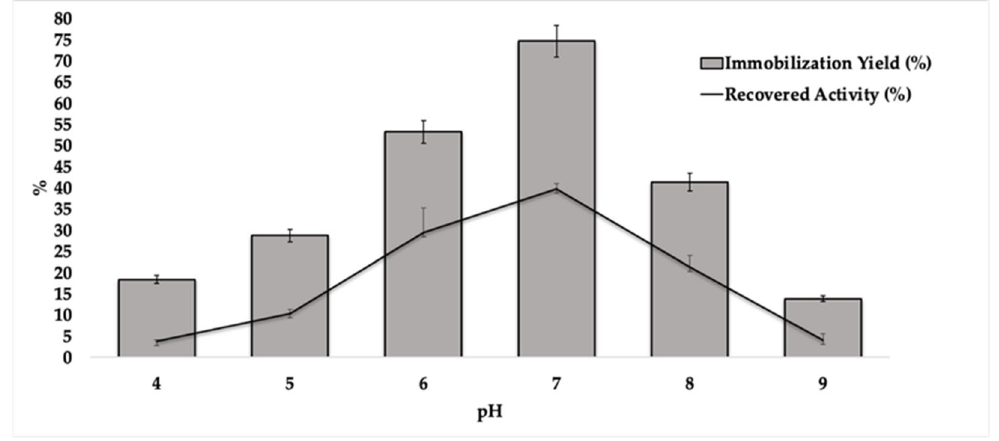
Figure 2. Effect on immobilization yield and recovered activity on immobilization of L Asp on CC support. Experimental conditions: 0.150 g of CC, 5 mL of laccase solution (0.1 g.mL − 1 ) at pH 4.0–9.0 (0.1 mol.L − 1 ), and 4 °C at 100 rpm under a shaker.